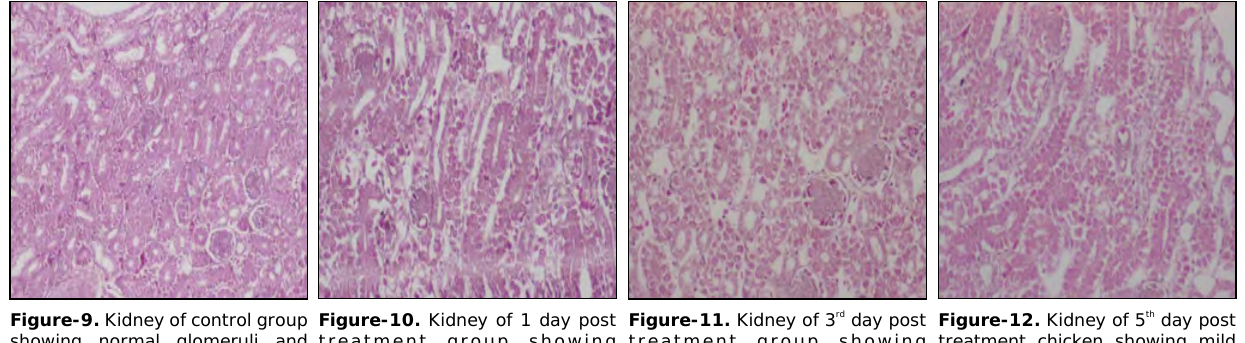
Figure-9. Kidney of control group showing normal glomeruli and tubular epithelial cells. H&E, x10.